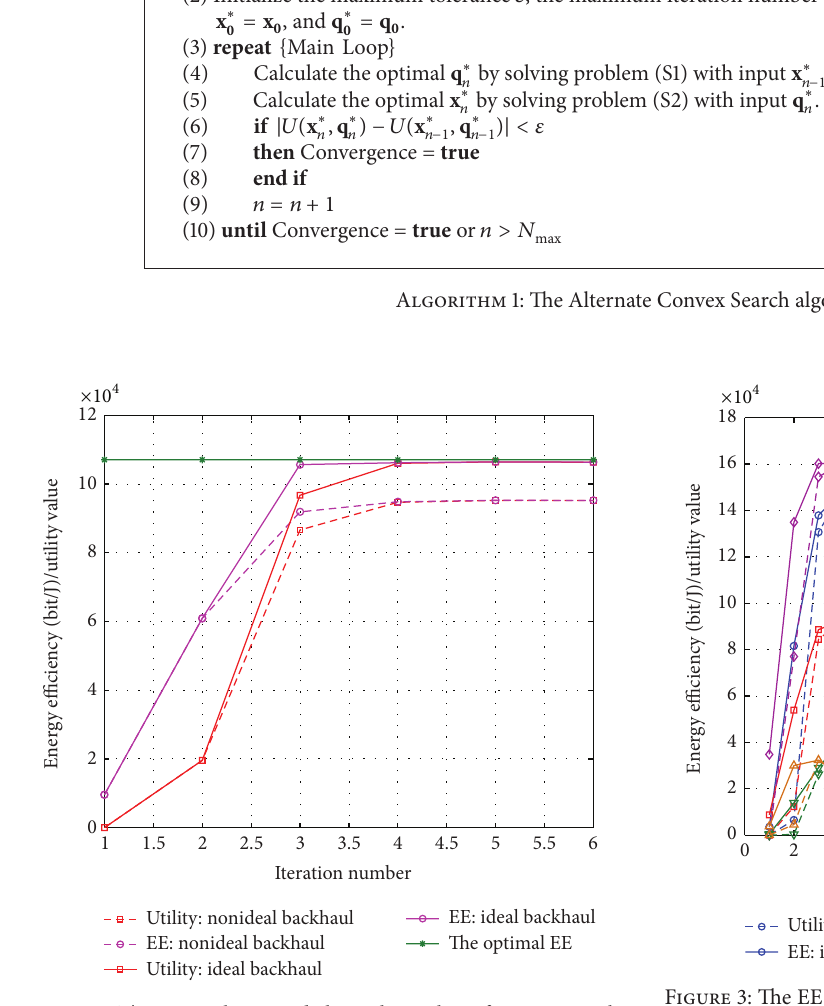
Figure 2: The network EE and the utility value of HetNets with respect to iteration number under ideal and nonideal backhaul scenarios.